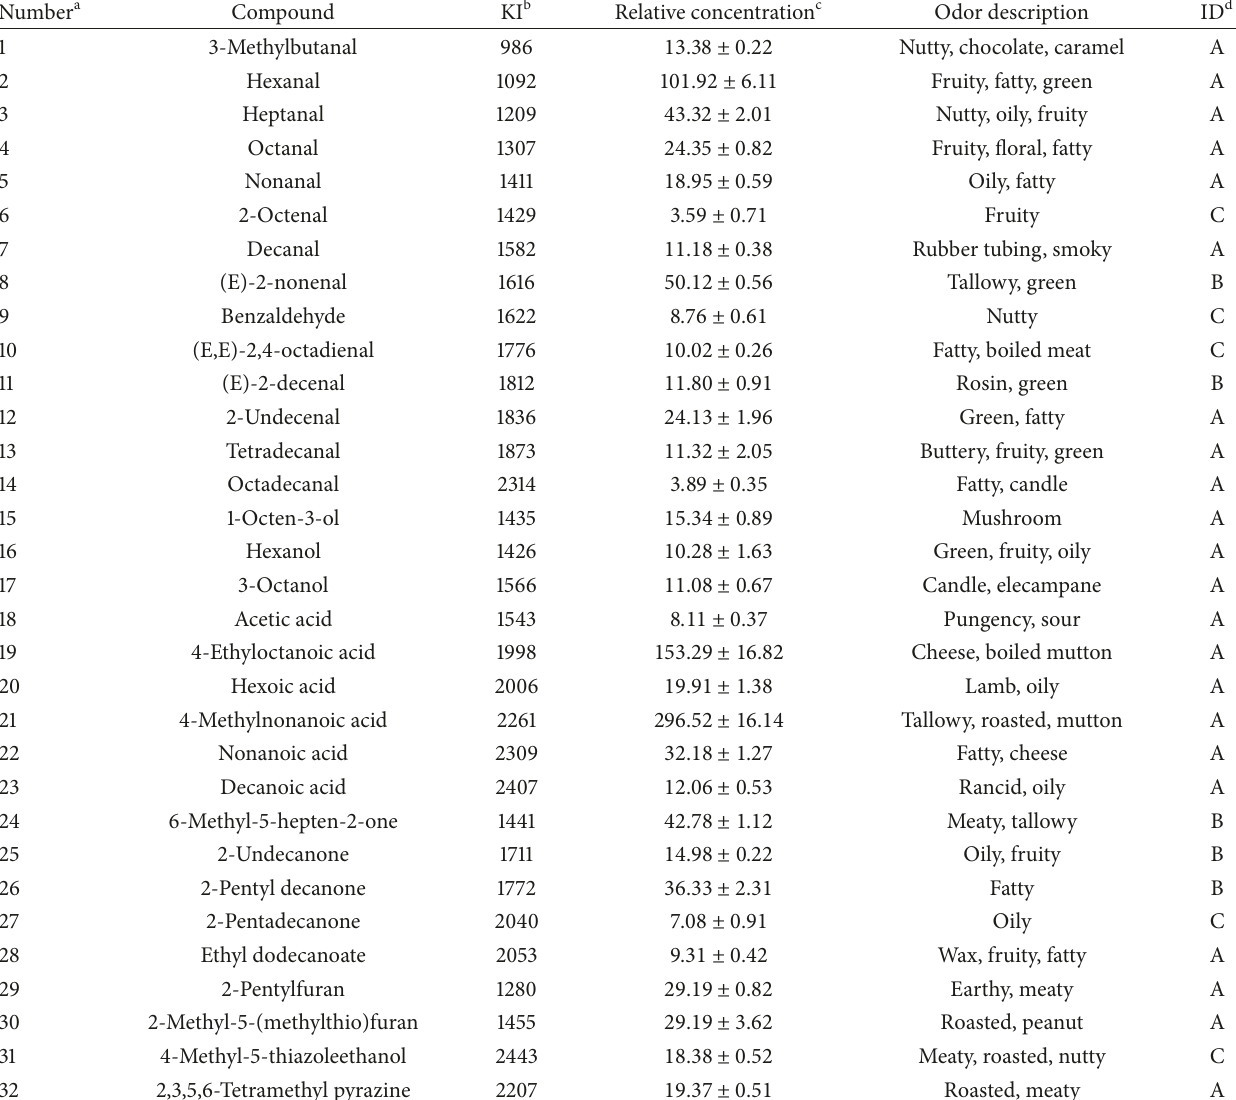
Table 1: The information of chromatographic fingerprint of active-odor compounds of